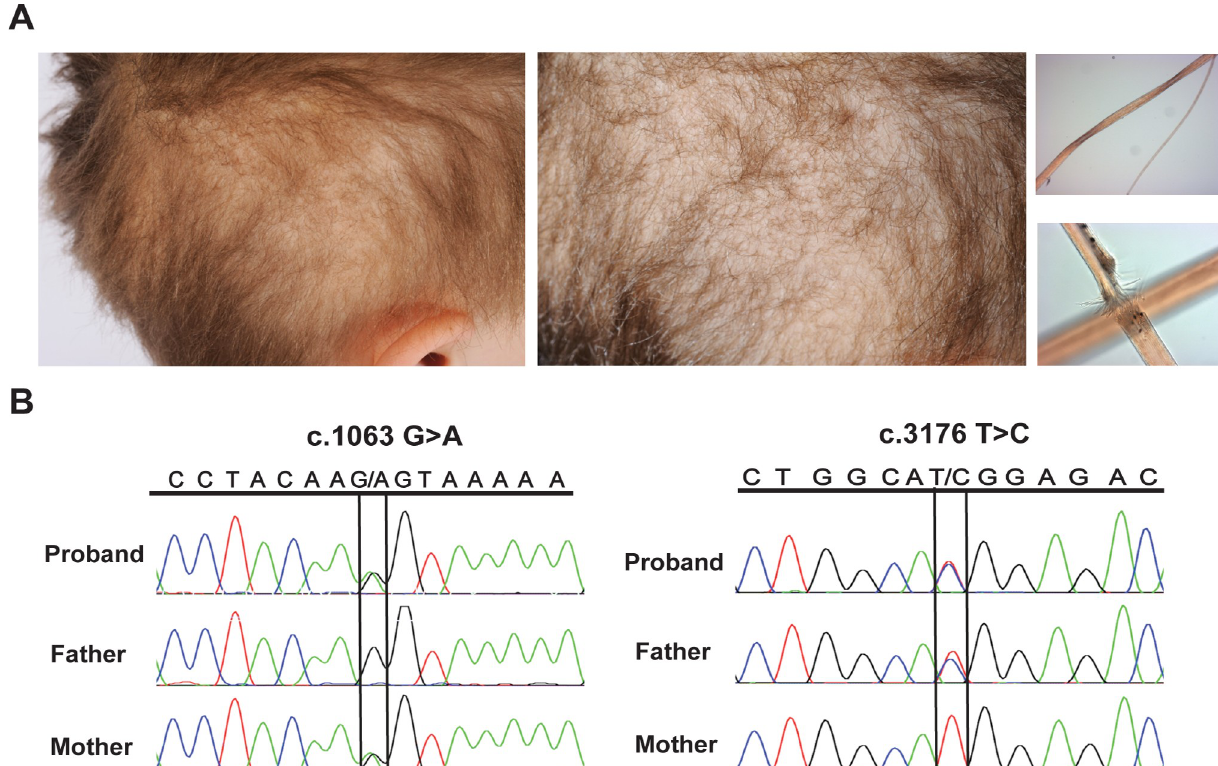
Fig 1. Hair phenotype and identification of HEPHL1 mutations. (A) Patient photographs taken at age 5 years show hair abnormalities. Sparse distribution of hair in the temporal area (left), and coarse hair texture (middle) are shown. Light microscopic examination of hairs showing pili torti (right upper) and trichorrhexis nodosa (right lower). (B) Sanger sequencing chromatograms showing biallelic mutations in the proband. The proband is a compound heterozygous for NM_001098672 (HEPHL1): c.1063G > A; p. Ala355Thr (inherited from the mother, left) and NM_001098672 (HEPHL1): c.3176T > C; p. Met1059Thr (inherited from the father, right).